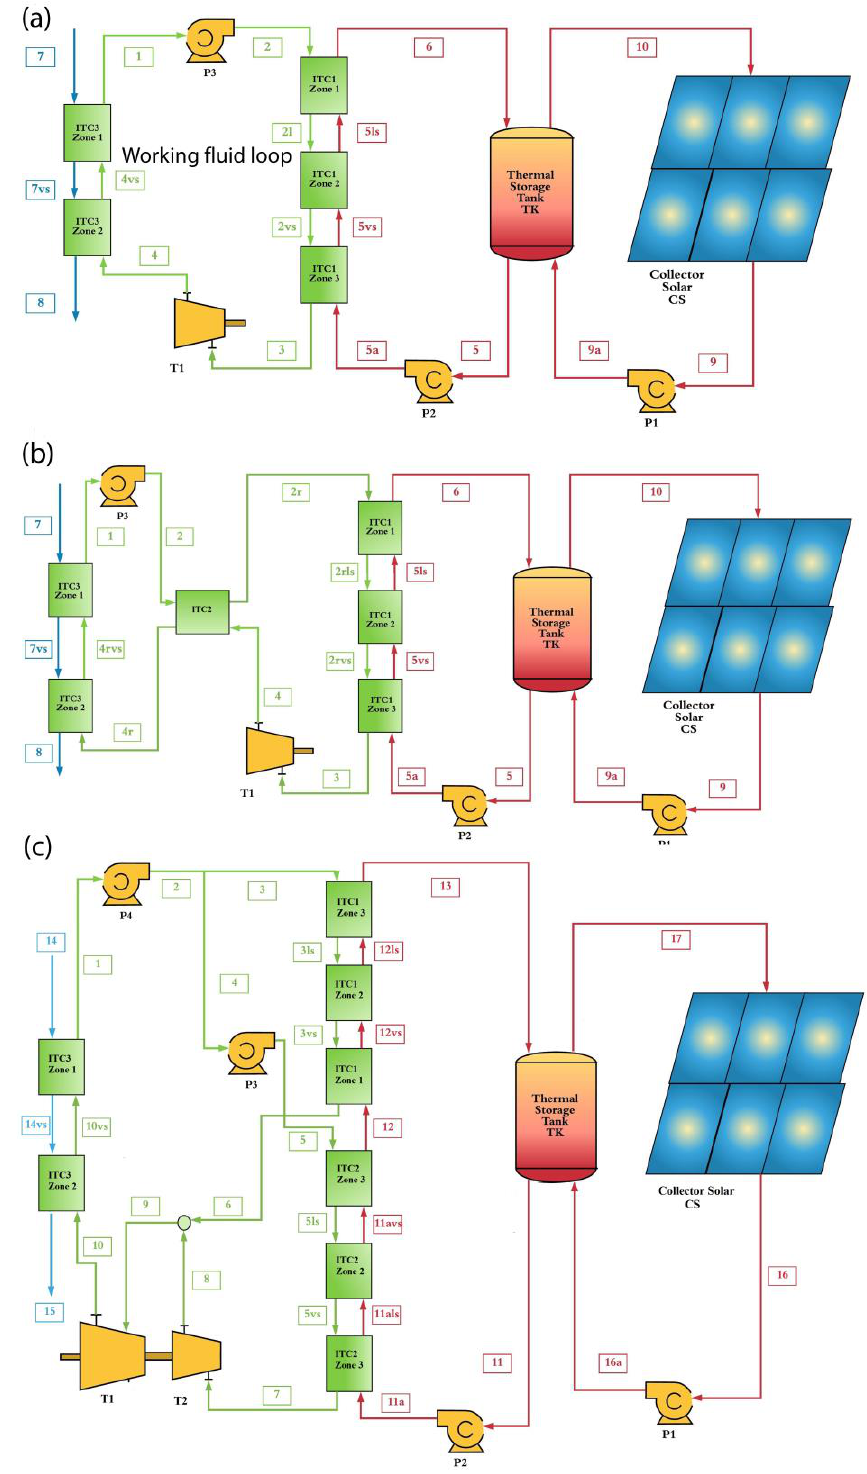
Figure 1. Analyzed configurations: ( a ) SORC, ( b ) RORC, and ( c ) DORC.